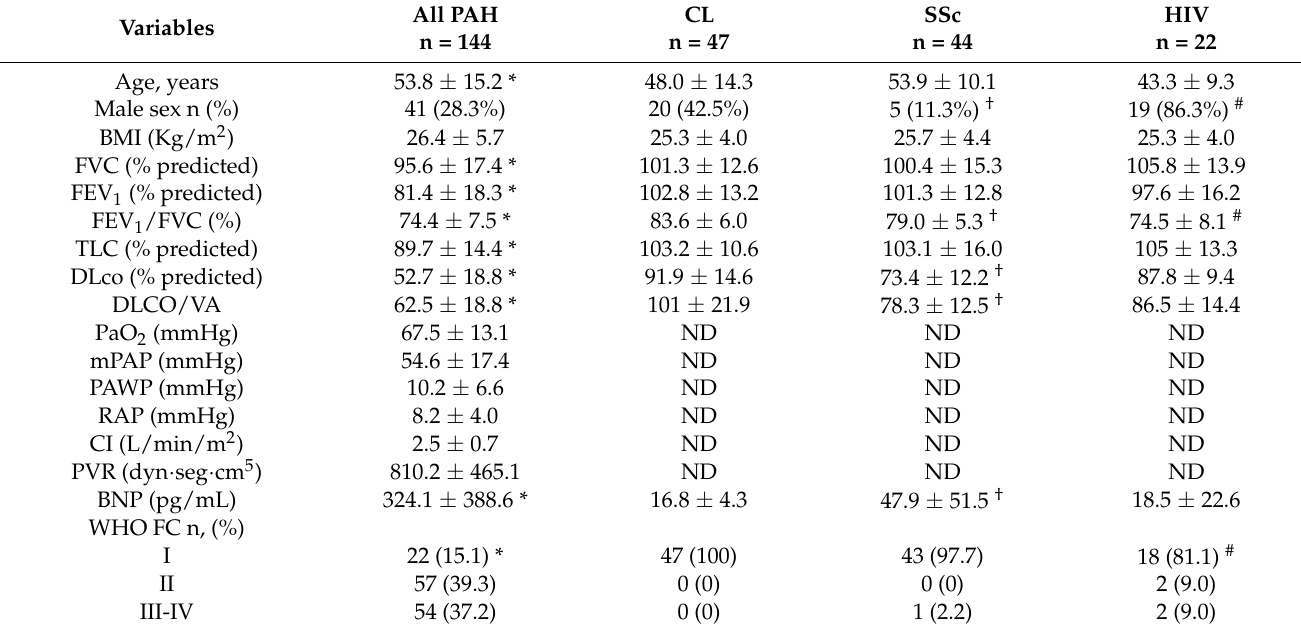
Table 1. Clinical and hemodynamic characteristics between pulmonary arterial hypertension patients and controls.